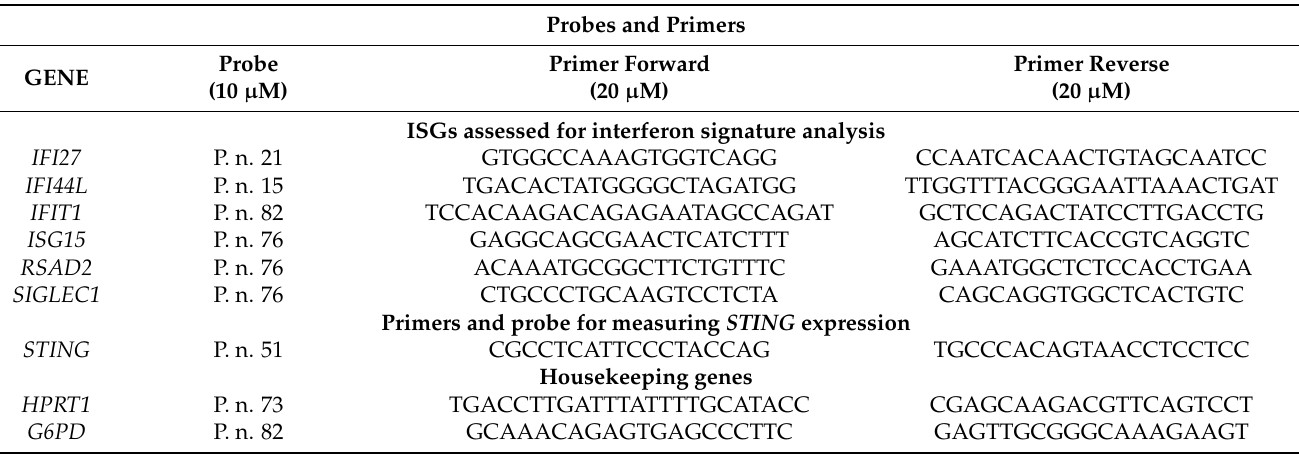
Table 8. Universal Probe Library (UPL) probes (Roche) and primers (Eurofins Genomics) for the six interferon-stimulated genes (ISGs) of interferon signature and STING analysis by Real-Time